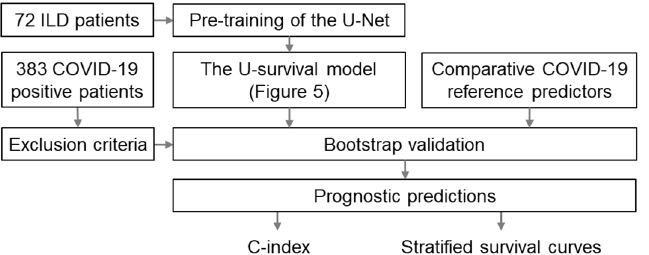
Figure 4. Flowchart of the key developments and evaluations. The U-survival model and the reference predictors are validated by use of bootstrapping with COVID-19 patients. The prognostic predictions are compared by use of the C-index and stratified survival curves. ILD Interstitial lung